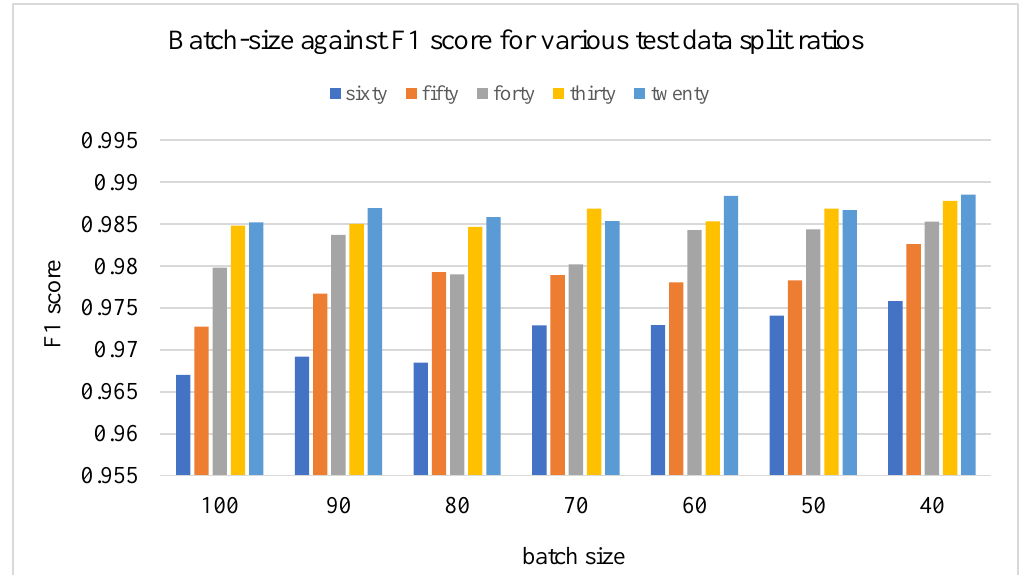
Figure 6. Split ratio against F1 score.